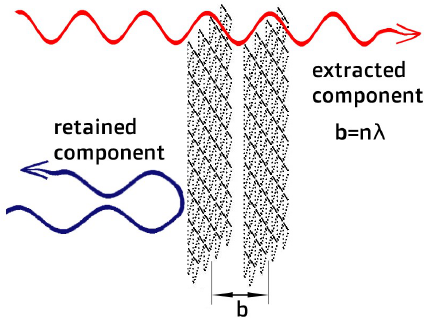
Figure 1. The passing of a mixture of isotopes through the bilayered membrane. The ability of particles to pass through membranes is described by the wave